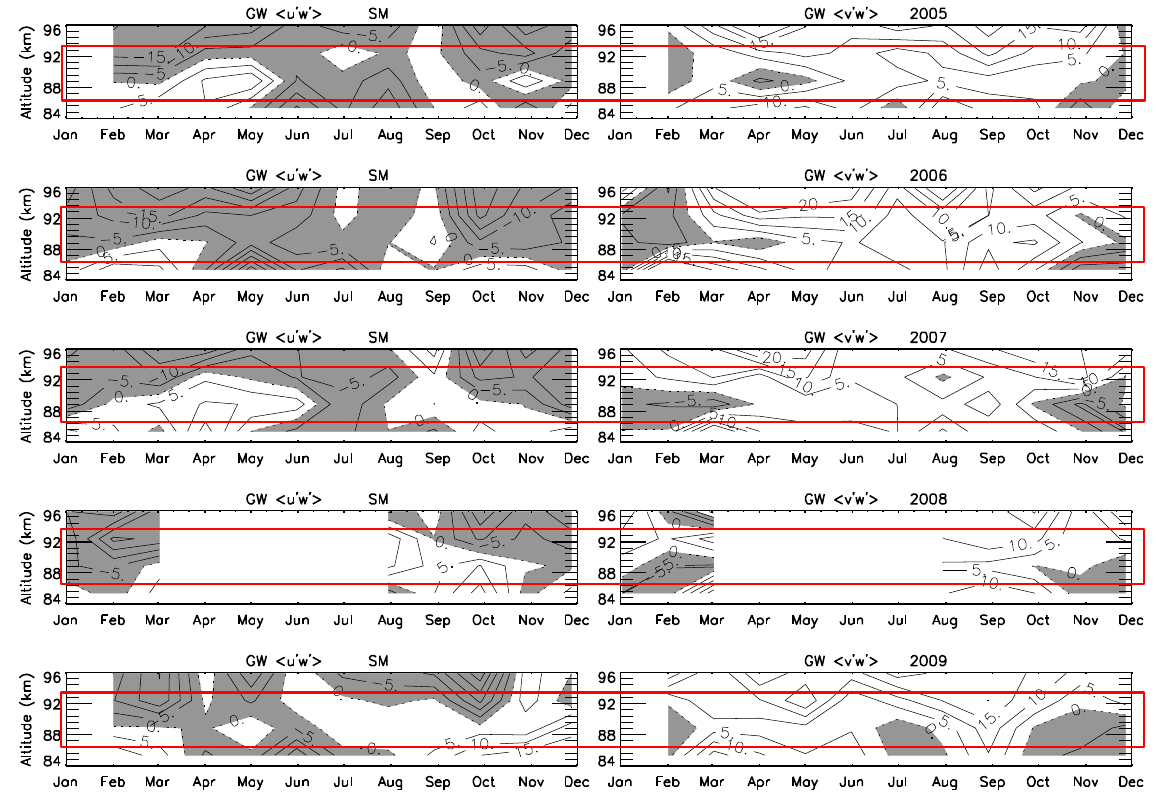
Figure 3. The same as Fig. 1 but for Santa Maria from February 2005 to 2009.